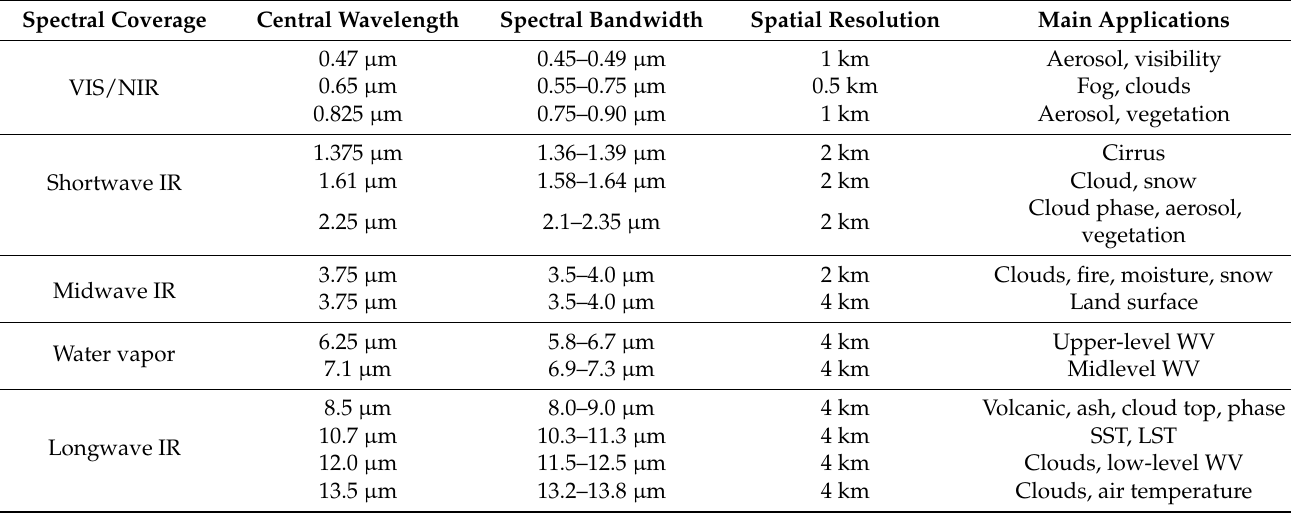
Table 1. FY4A satellite parameters by channel *.